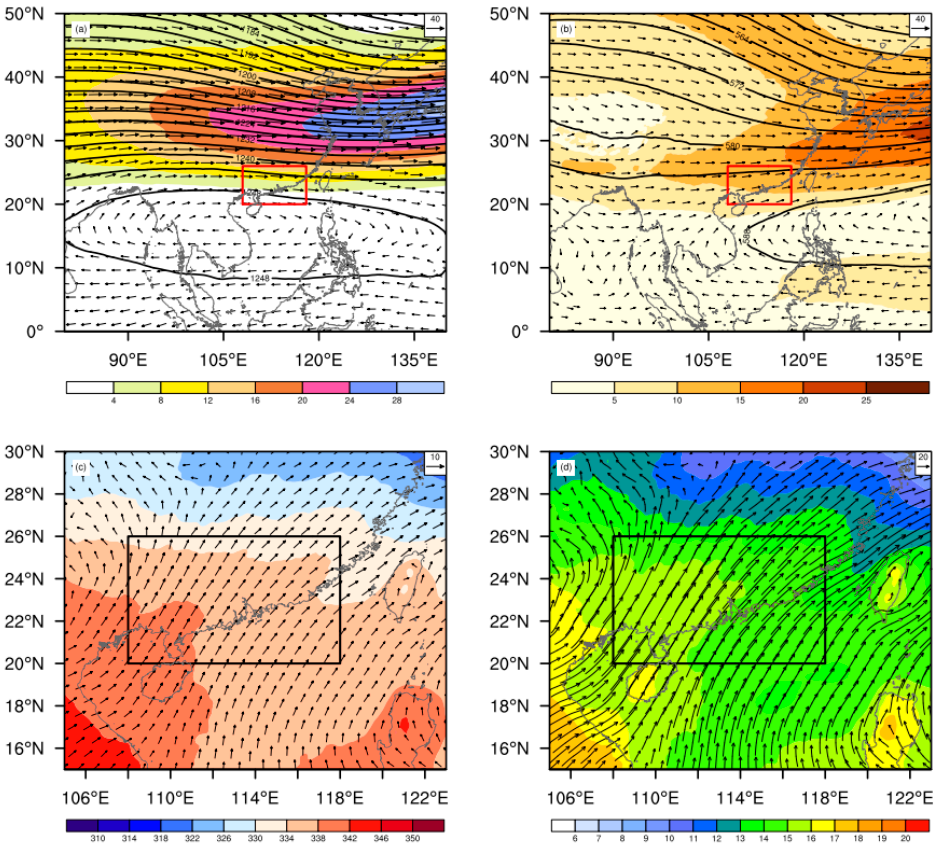
Figure 6. Wind fields (arrows and shaded, unit: m ∙ s − 1 ) and geopotential height fields (black contours, unit: m) during April–June in ( a ) East Asia at 200 hPa and ( b ) Pan-South China at 500 hPa; ( c ) wind field (arrows, unit: m ∙ s − 1 ) and potential pseudo-equivalent temperature (shaded, unit: K) in Pan-South China at 850 hPa; ( d ) water vapor flux (arrows and shaded, unit: g ∙ cm − 1 ∙ hPa − 1 ∙ s − 1 ) in Pan-South China at 850 hPa. Both the red and black boxes represent Guangdong Province.